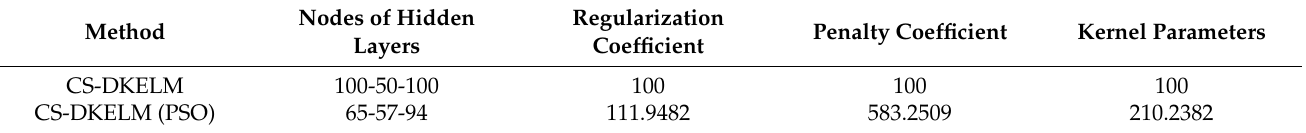
Table 4. Comparison of